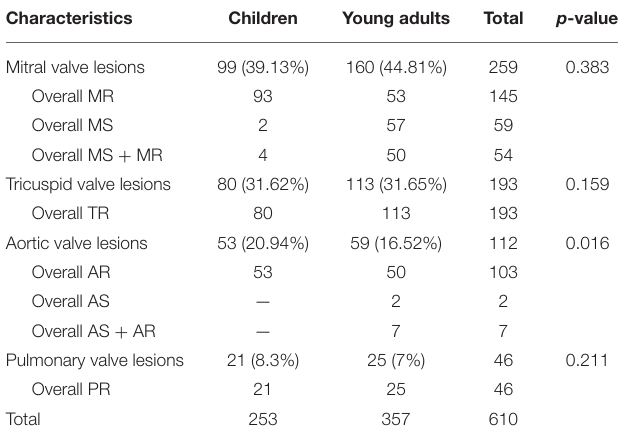
TABLE 2 | Clinical manifestations and laboratory investigation findings in RHD cases.